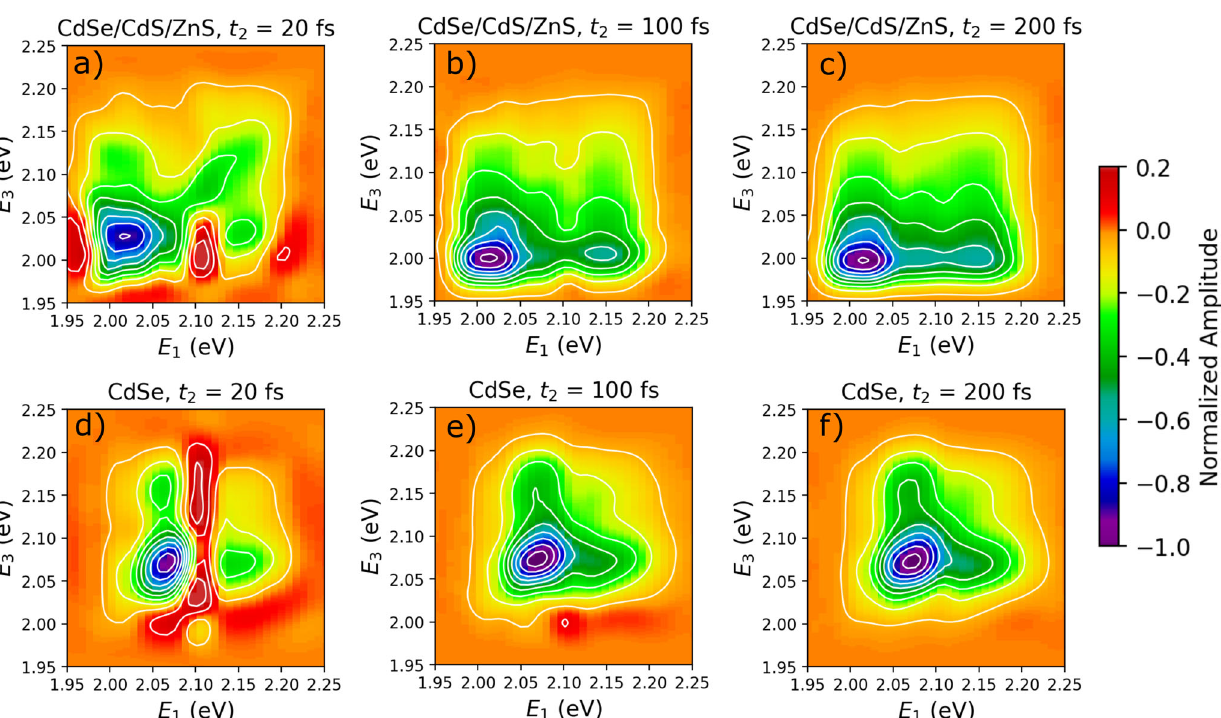
Fig. 2 Overview of two-dimensional electronic spectroscopy (2DES) signals as contour plots. Each panel corresponds to a fi xed population time t 2 , where t 2 is the time delay between the pump pulses and the probe pulse. a – c 2DES spectra of CdSe/CdS/ZnS at t 2 = 20 fs, 100 fs, and 200 fs. d – f 2DES spectra of CdSe at t 2 = 20 fs, 100 fs, and 200 fs. The color bar corresponds to the normalized amplitude of the 2DES signal. At t 2 = 20 fs the 2DE spectra are distorted due to the overlap between the three laser pulses. At t 2 = 100 fs the pulse overlap artifacts are gone. For CdSe/CdS/ZnS, the X 2 – X 1 peak in lower right-hand corner grows between t 2 = 100 and 200 fs, while CdSe does not show signi fi cant change from t 2 = 100 to 200